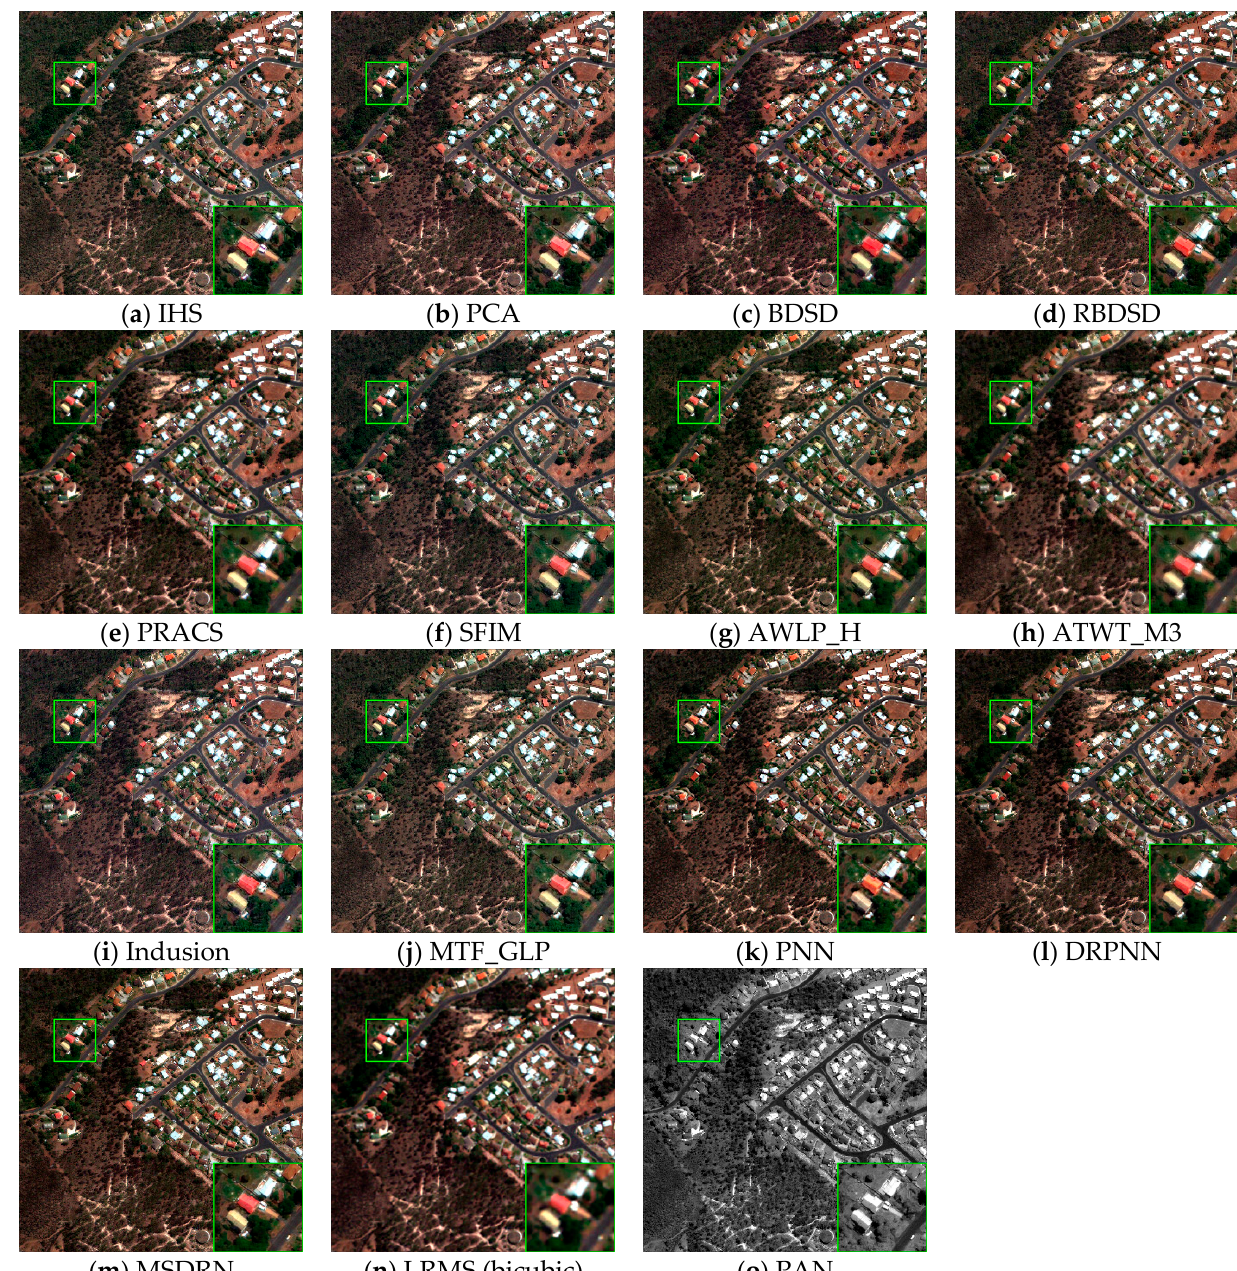
Figure 8. An example of real data experiments conducted on the GeoEye-1 dataset. From ( a – o ) IHS, PCA, BDSD, RBDSD, PRACS, SFIM, AWLP_H, ATWT_M3, Indusion, MTF_GLP, PNN, DRPNN, MSDRN, LRMS (bicubic), PAN.